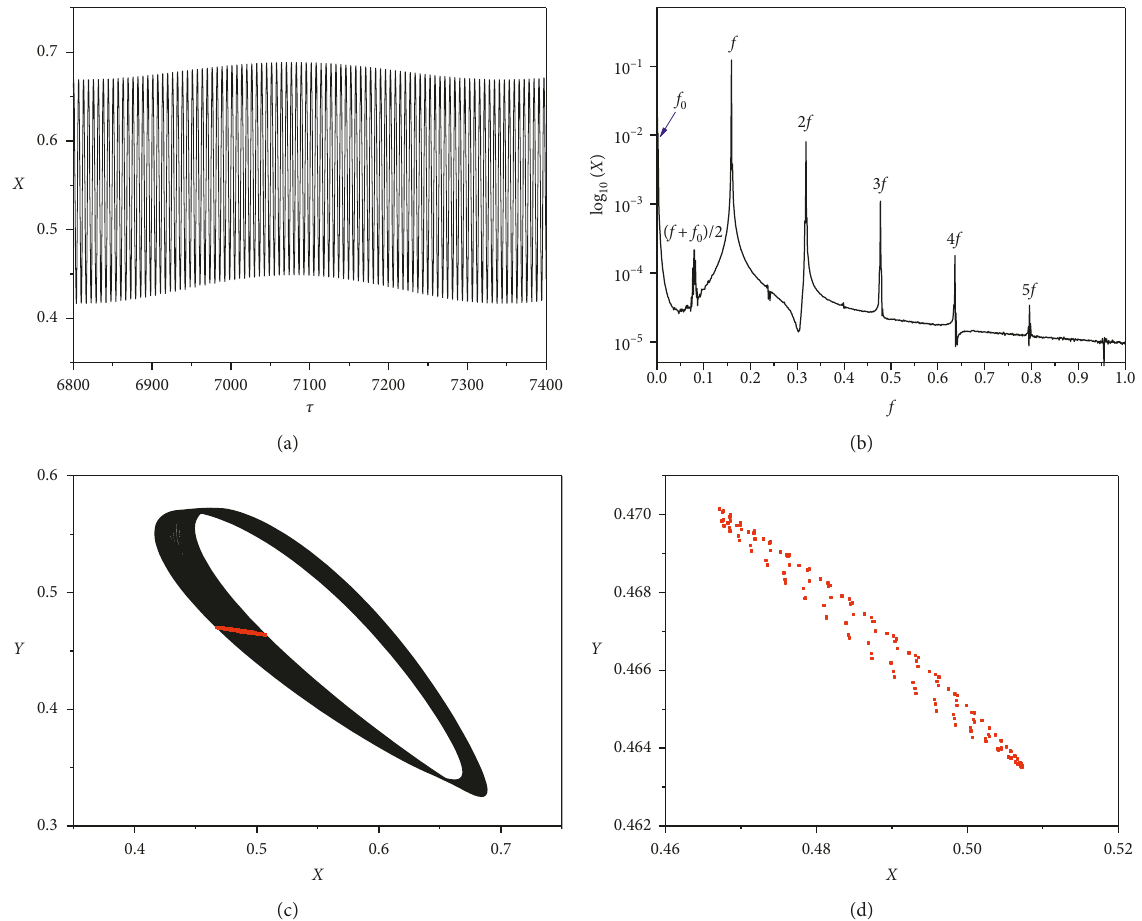
Figure 12: (a) Displacement. (b) Frequency response. (c) Rotor orbit. (d) Poincar´e map where